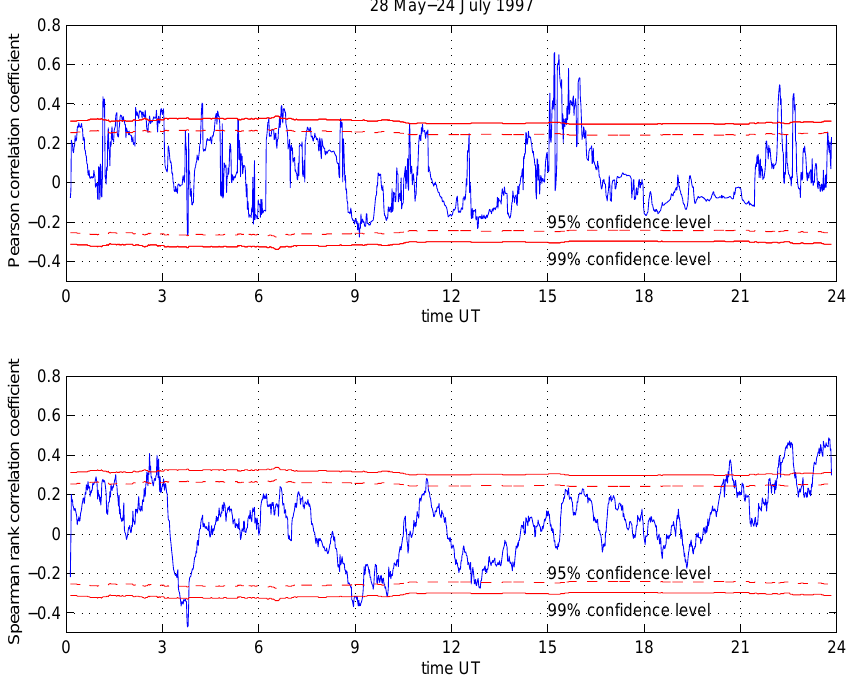
Fig. 5. Same as Fig. 4, except that only data for which the square of absorption was less than 1dB 2 were used when calculating the correlation